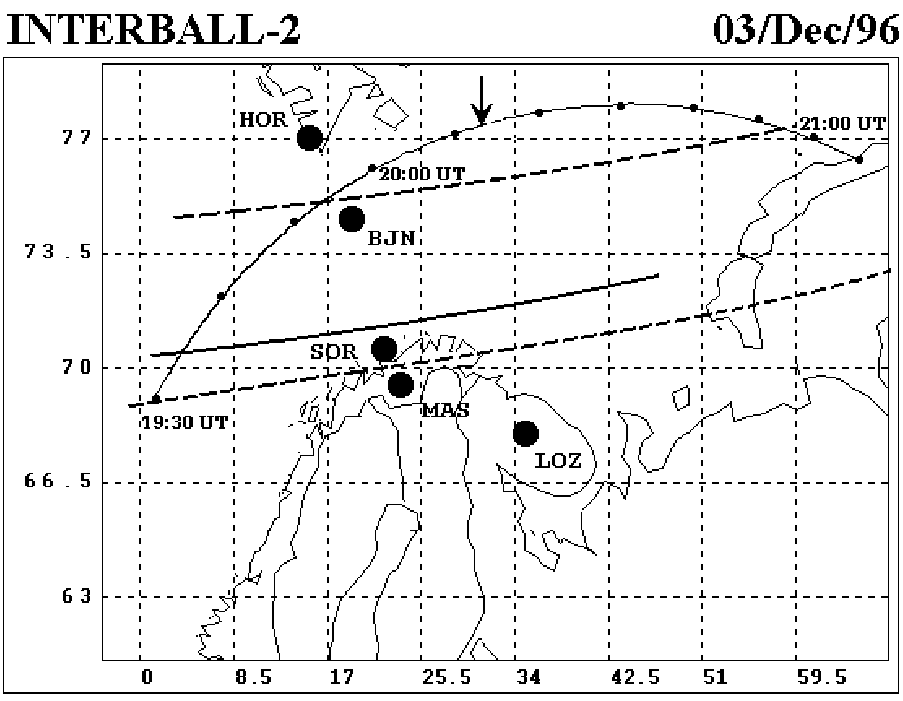
Fig. 1. Projection of the INTERBALL-2 orbit on 3 December 1996 (dots on the trajectory mark 10-min intervals) and location of magnetic stations of the IMAGE network (big points). Boundaries of the auroral particle precipitation zone (dashed lines) discovered from the ground and satellite observations are also shown, as well as the position of the bright auroral arc inside of the precipitation zone. The arrow marks the projection of the satellite along magnetic field lines on the ionosphere for the onset of auroral hiss near 20:13 UT on INTERBALL-2 (see Fig.